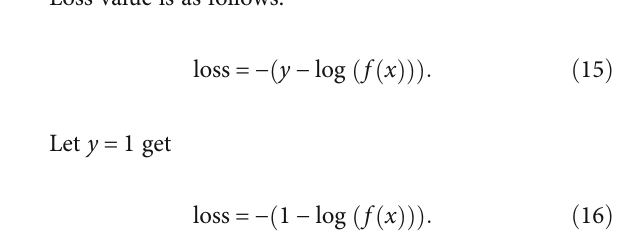
Figure 5: Gray scale image H